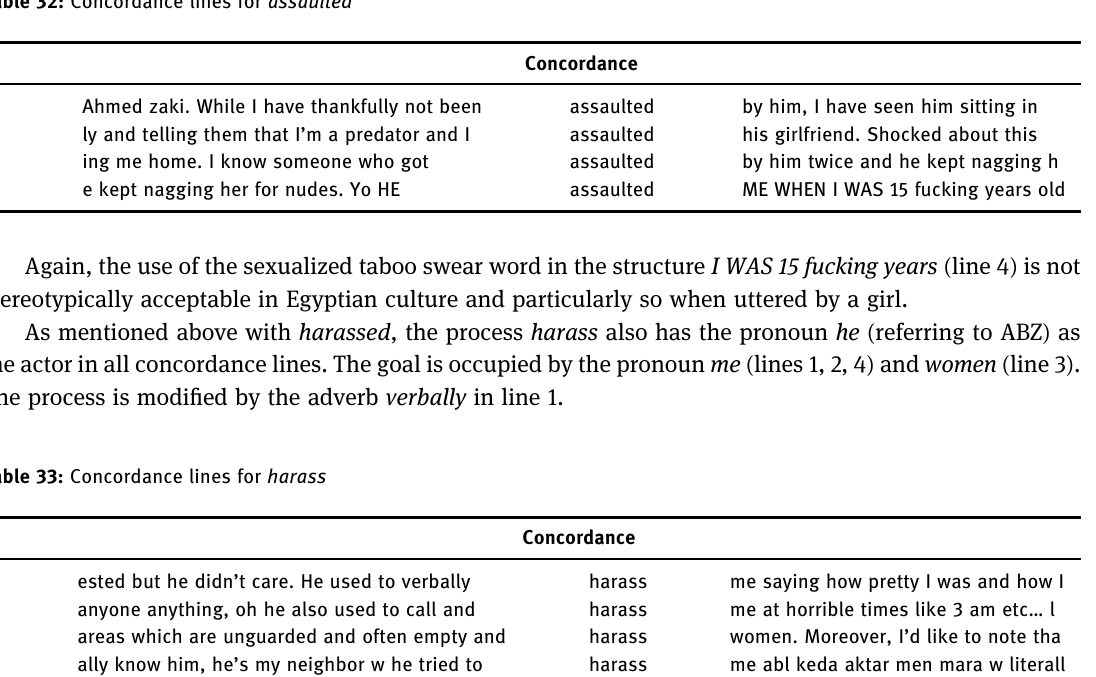
Table 32: Concordance lines for assaulted